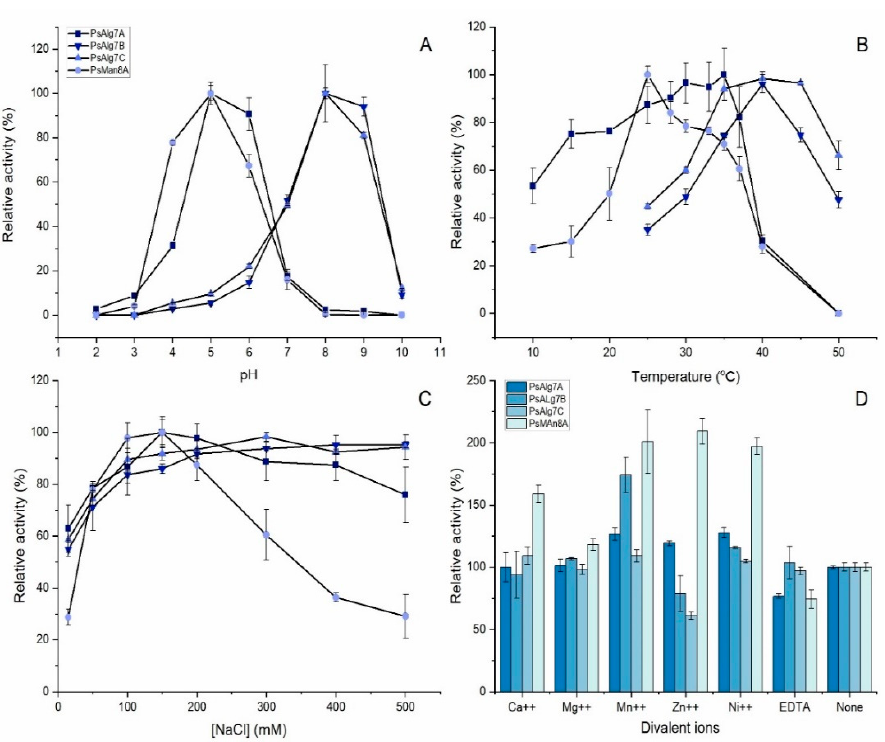
Figure 4. Biochemical characterization of the four alginate lyases PsAlg7A, -B, -C, and PsMan8A on polyM under std. assay conditions: ( A ) pH-optimum; ( B ) temperature-optimum; ( C ) effect of NaCl; ( D ) effect of divalent ions and EDTA with 150 mM NaCl. Error bars represent standard errors on triplicates. Table 1. Kinetic parameters and specific activities (SA) for the four alginate lyases on commercial substrates. The parameters were calculated by fitting the Michaelis–Menten model in the program Origin. ± represents standard errors on triplicates.